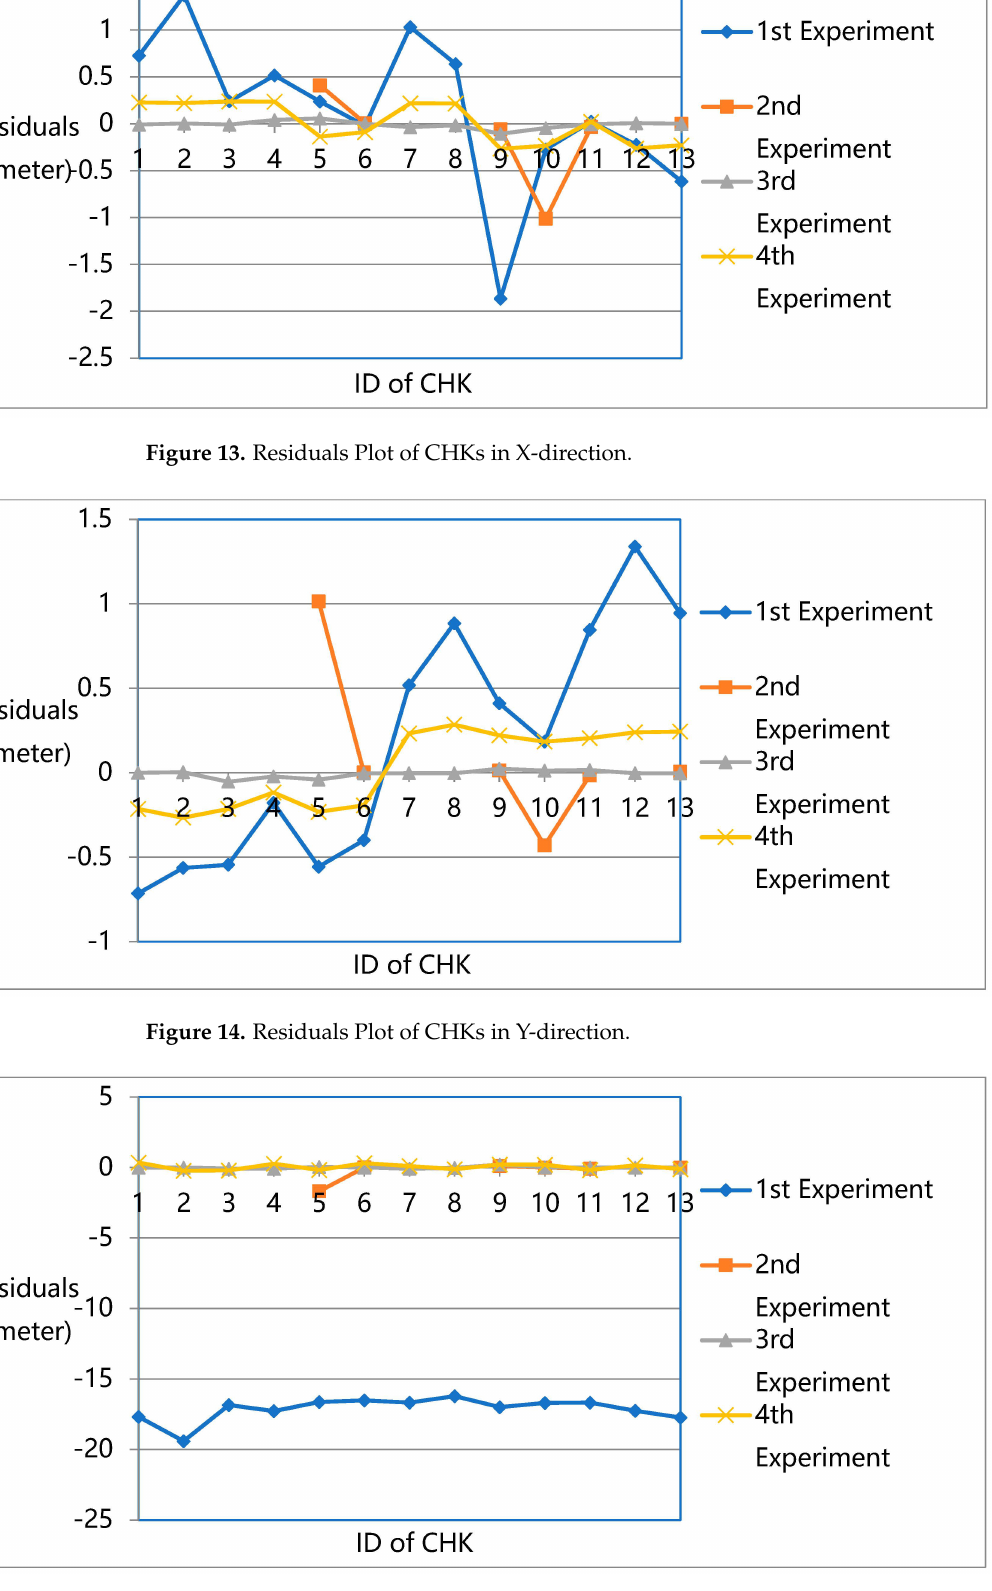
Figure 15. Residuals Plot of CHKs in